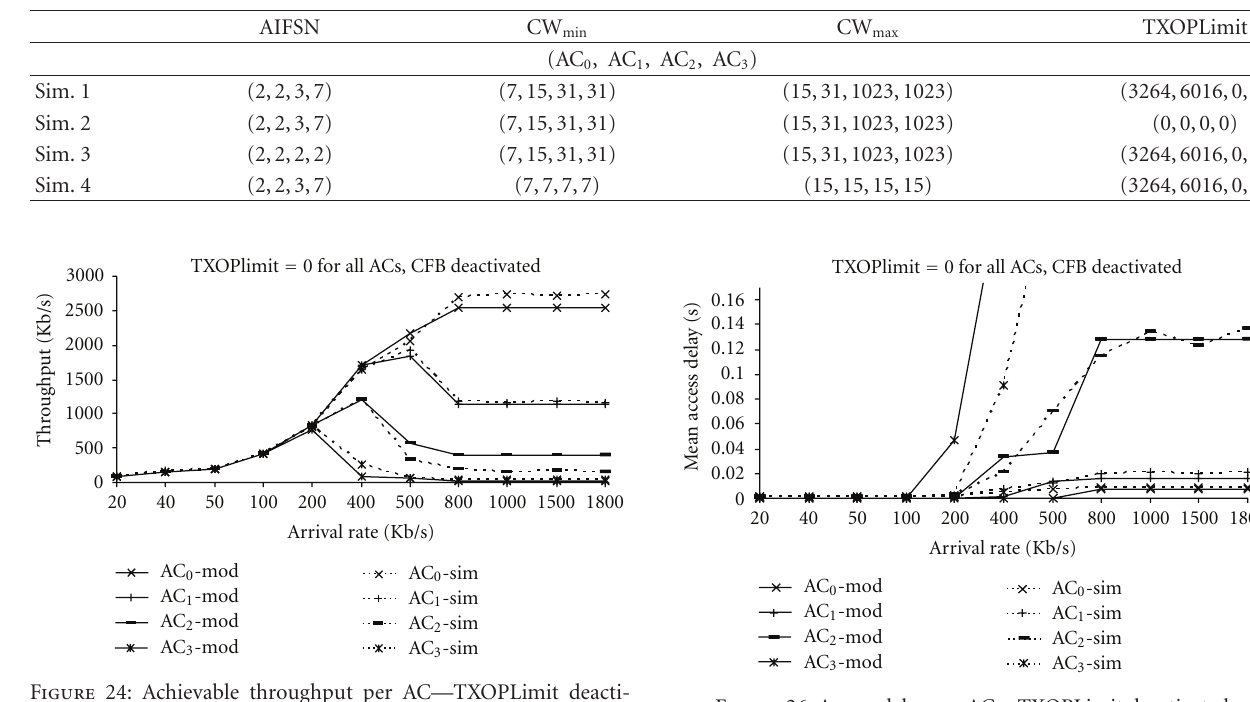
Table 4: EDCA parameters for di ff erent simulation scenarios.